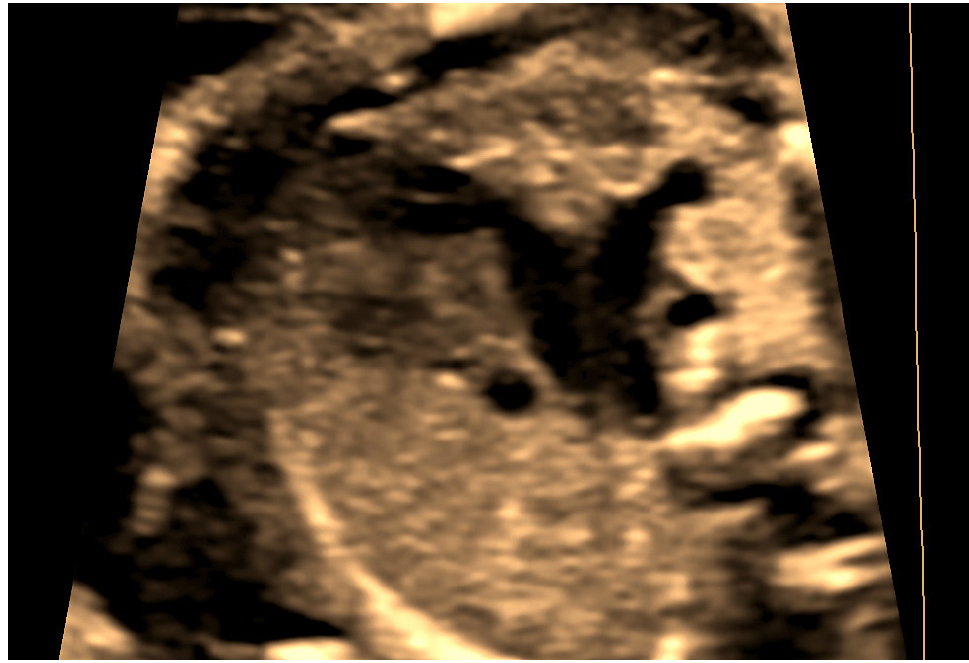
Figure 1. Transversal section at the TTVV—four vessels can be seen—from left to right, persistent left superior vena cava (PLSVC), main pulmonary artery (MPA), aortic arch (AoA) and right superior vena cava (SVC).